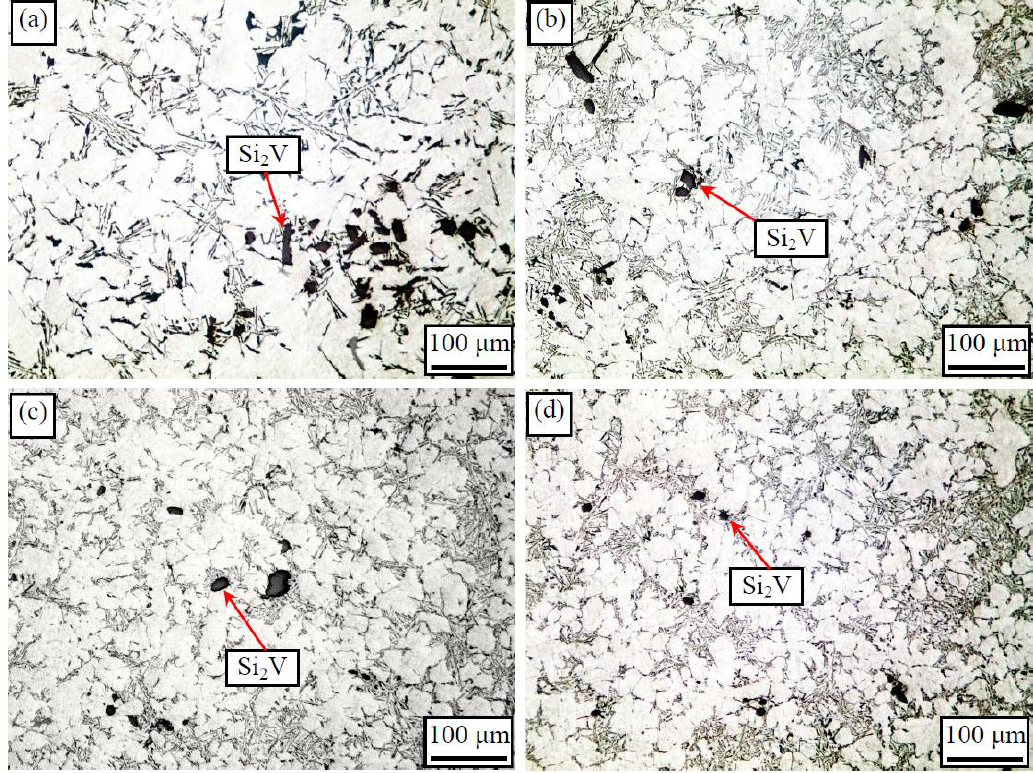
Figure 11. Optical micrographs of as-cast HPRSC A3 alloy treated by UV-ES compound field: ( a ) 0 MPa; ( b ) 100 MPa; ( c ) 200 MPa; ( d ) 400 MPa.